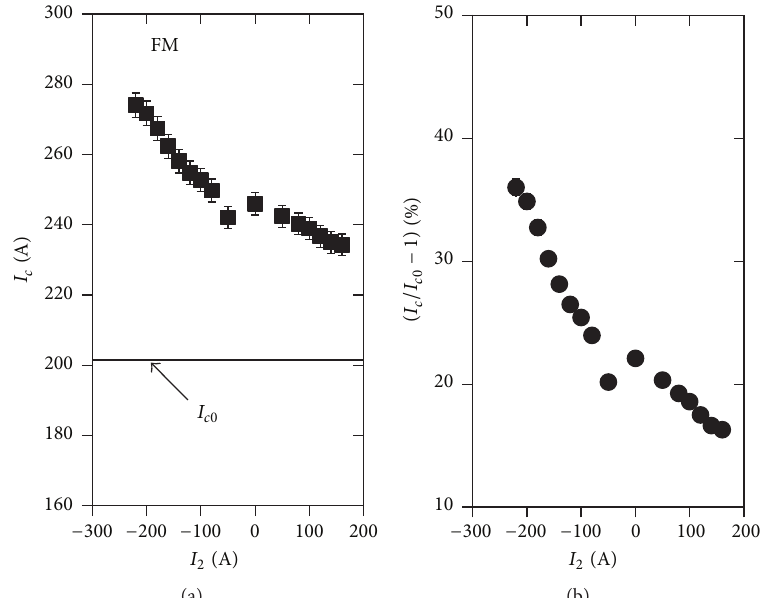
Figure7:(a) 𝐼 𝑐 versustheappliedcurrenttotheneighboringtapesand(b)increaseof 𝐼 𝑐 withrespecttotheneighboringcurrentforthree-layer stacked conductor with FMs.